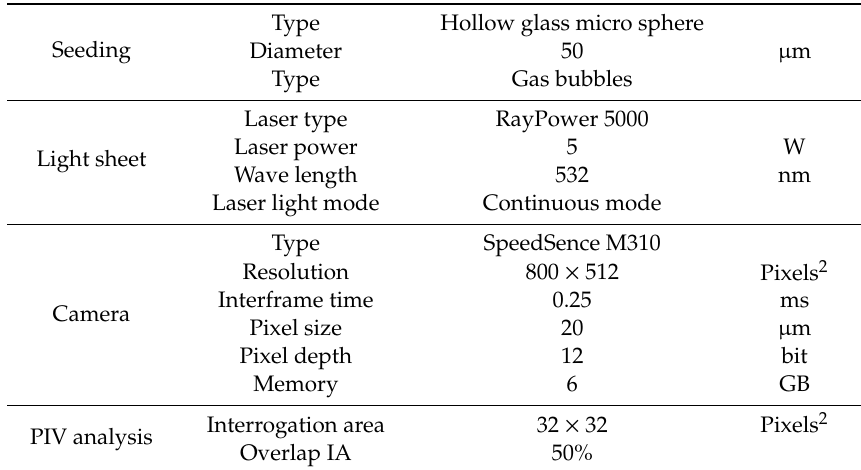
Figure 2. Schematic drawings of the bubble generator system with a top view synchronized with laser and high-speed camera. Table 2. Overview of PIV